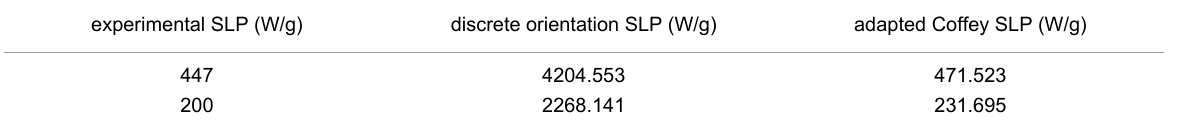
Table 2: Experimentally obtained and numerically calculated (adapted Coffey method to local magnetic fields and common discrete orientation model for τ N ) values of SLP.